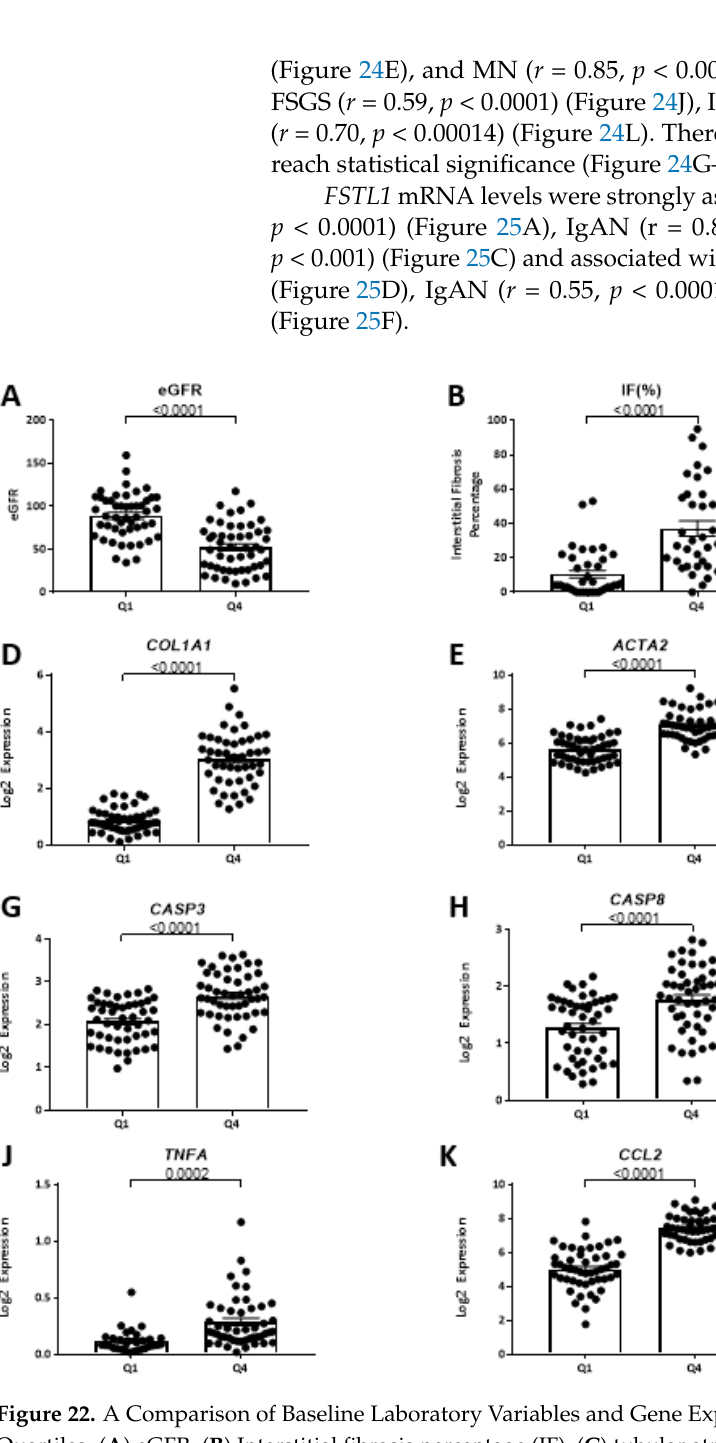
Figure 22. A Comparison of Baseline Laboratory Variables and Gene Expression Levels Between First and Fourth FSTL1 Quartiles. ( A ) eGFR. ( B ) Interstitial fibrosis percentage (IF). ( C ) tubular atrophy percentage (TA). ( D ) Collagen Type I Alpha 1 Chain ( COL1A1 ) expression. ( E ) Actin Alpha 2, Smooth Muscle ( ACTA2 ) expression. ( F ) Transforming growth factor beta ( TGFB1 ) expression. ( G ) Caspase 3 ( CASP3 ) expression. ( H ) Caspase 8 ( CASP8 ) expression. ( I ) BCL2 Associated X, Apoptosis Regulator ( BAX) expression. ( J ) Tumor Necrosis Factor ( TNFA ) expression. ( K ) C-C Motif Chemokine Ligand 2 ( CCL2 ) expression. ( L ) Fibronectin 1 ( FN1 ) expression. Values are the mean ± SEM (black bars). p values were determined by Student’s t tests, and significance was defined as a p value <